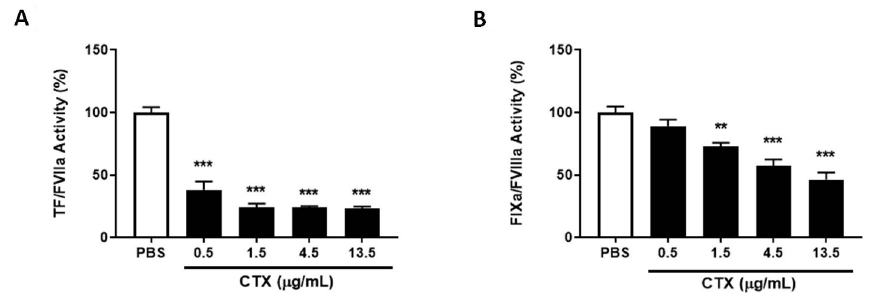
Figure 3. Intrinsic and extrinsic tenase complex activity. CTX (0.5-13.5 µg/mL) or PBS (control) were incubated with (A) TF/FVII or (B) FIX/FVIIIa/PL and FX activation measured. The results were expressed as complex activity (%) ± SEM, considering 100% activity when incubated with PBS (control). In both experiments the groups were performed with n = 5, ***p < 0.001 and **p < 0.01 vs. each respective control group. Statistical analysis was performed using one- way ANOVA followed by Dunnett’s